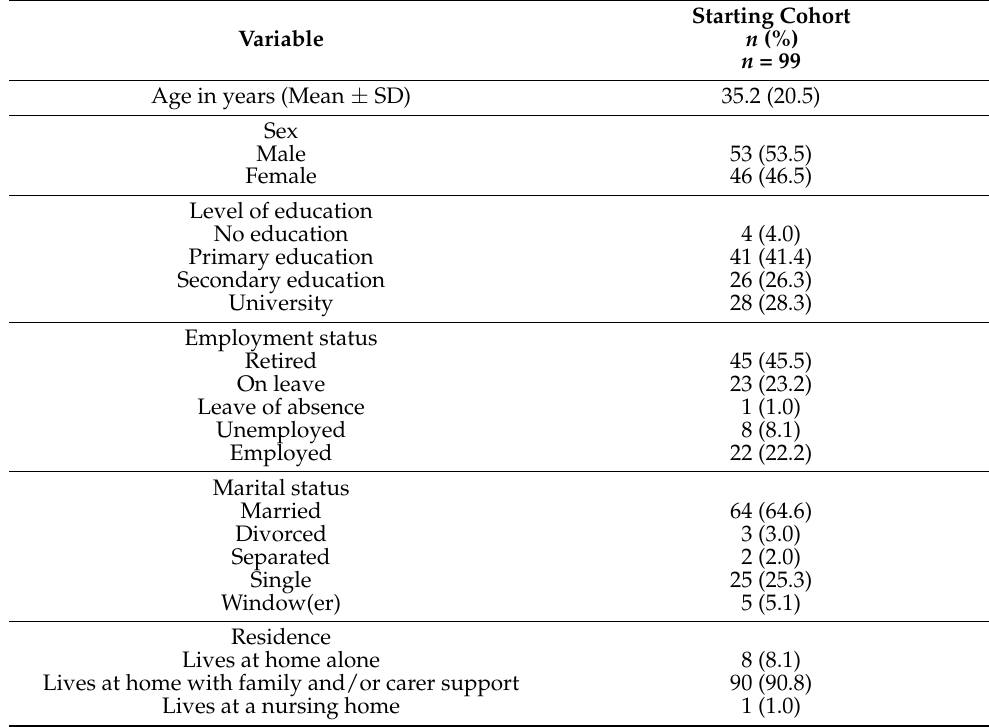
Table 1. Sociodemographic characteristics of the patients who participated in the study.